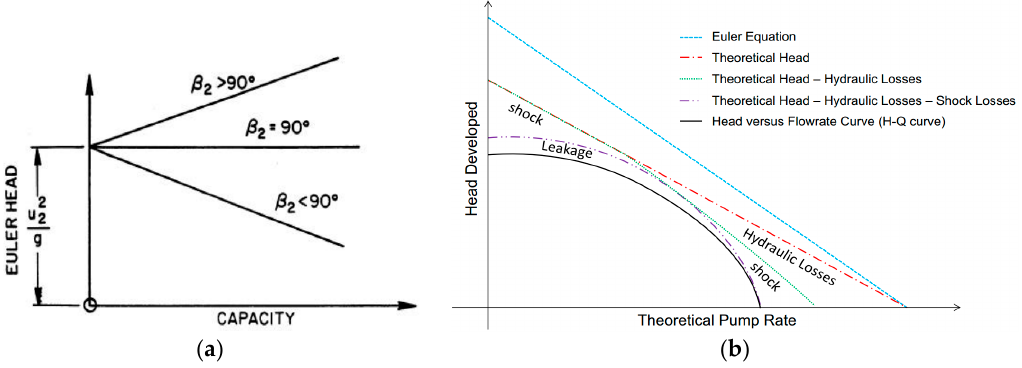
Figure 4. Schematic of head curves. ( a ) Euler heads with different outlet blade angles; ( b ) actual head after deducting losses [7].